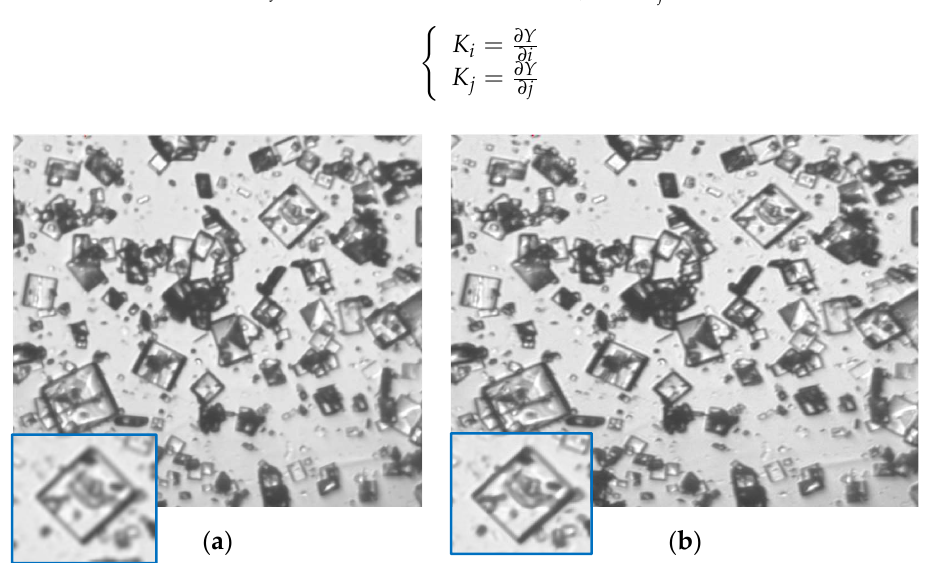
Figure 5. Segmentation results of different segmentation: ( a ) the in situ captured image ( M Ten = 35.49); ( b ) the preprocessed result ( M Ten =